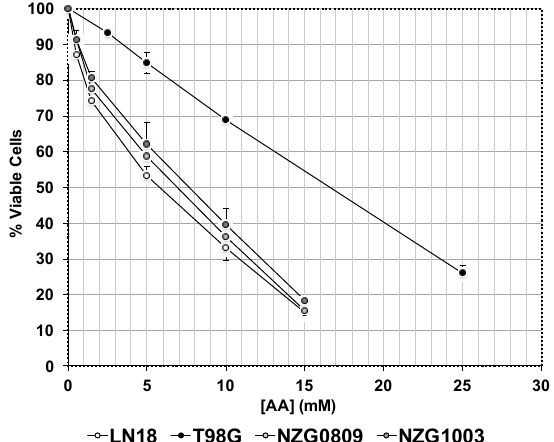
Figure 1. Sensitivities of different glioblastoma (GBM) cells to high dose ascorbic acid (AA). Cells were exposed to different concentrations of AA. Viability was measured by Trypan blue exclusion after 48 h. Values are averages ± standard error of the means (SEM) of at least 3 independent experiments in triplicate.